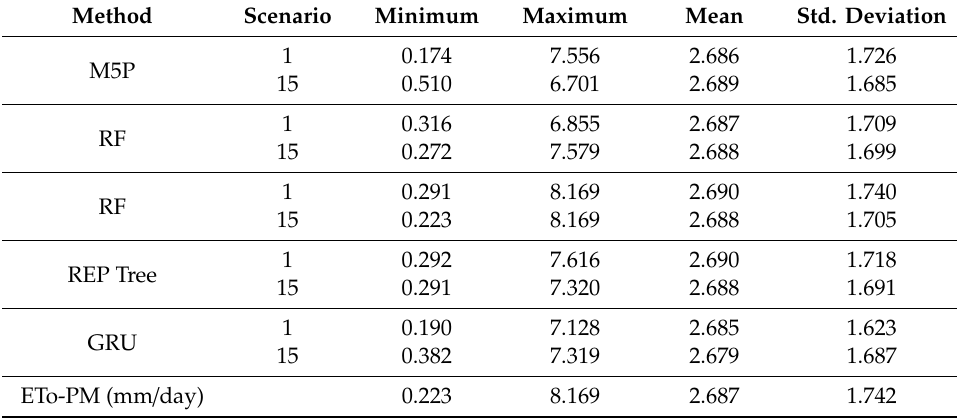
Table 9. Comparison of ETo statistical features based on used